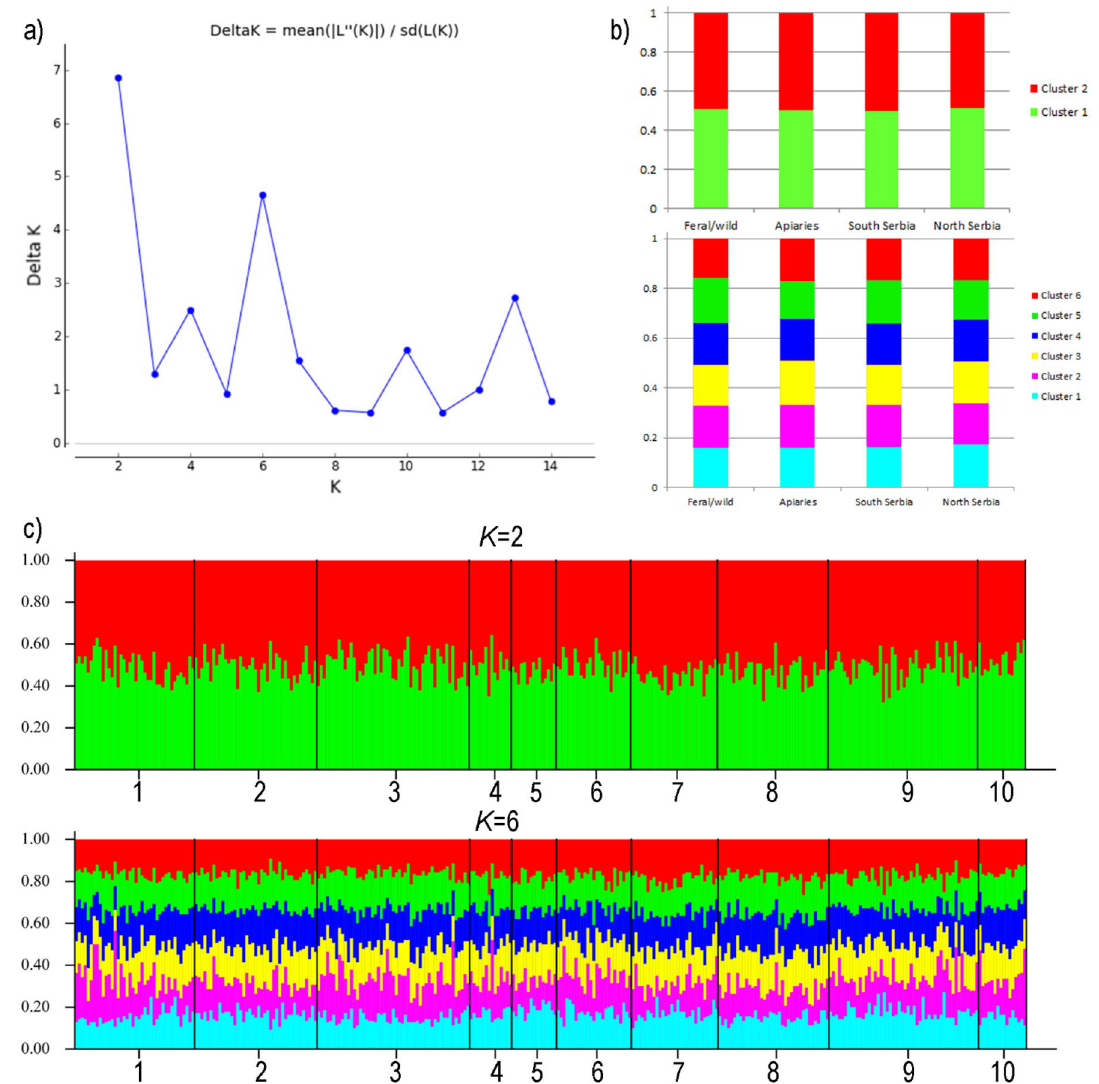
Figure 5. ( a ) Δ K mean for the assumed number of genetic clusters. ( b ) Proportions of inferred STRU CTU RE clusters (K = 2 and K = 6). ( c ) Proportions of the inferred STRU CTU RE clusters (K = 2 and K = 6) from the individuals. 1—BG feral, 2—BG managed, 3–6—South Serbia (3—Leskovac, 4—Vlasina, 5—Tromeđa, 6—Stara planina), 7–10—North Serbia (7—Fruška gora, 8—Subotica, 9—Deliblatska peščara,